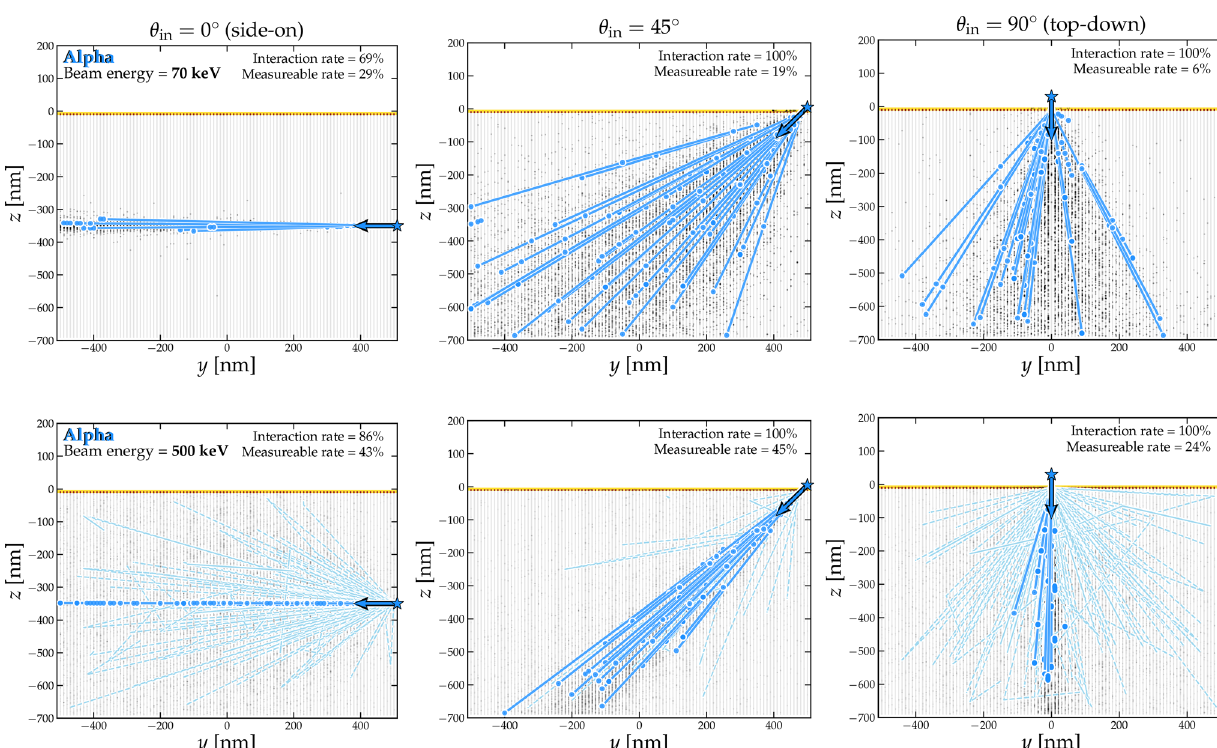
Fig. 5 Distribution of DNA breakage sites for alpha particles for two incident energies, 70 keV (top row) and 500 keV (bottom row), and for three different incident beam angles: θ in = 0 ◦ (left), θ in = 45 ◦ (mid- dle), and θ in = 90 ◦ (right). As in Fig. 4, breakage sites are denoted by filled circles and primary particle tracks by thick lines. Dashed lines